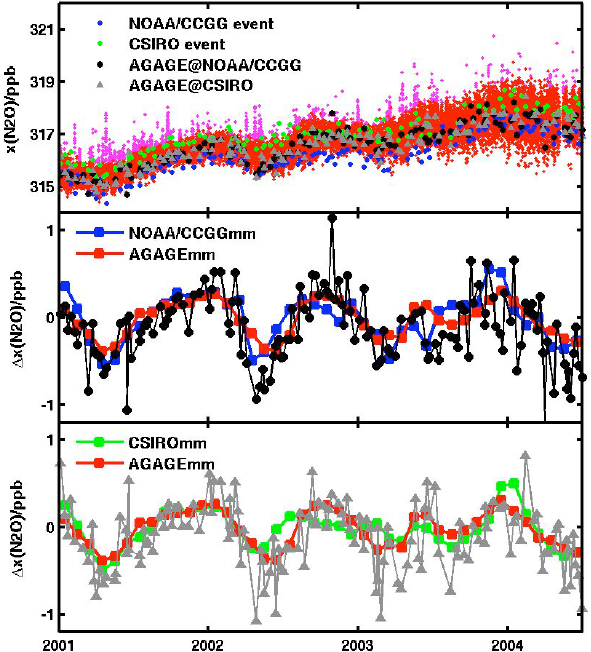
Fig. 4. (a) Same as Fig. 3a but for Cape Grim,Tasmania. Green dots are CSIRO event data. Gray triangles are AGAGE data sub- sampled at the time of CSIRO flask collection. (b) AGAGE data subsampled at NOAA/CCGG flask times compared to AGAGE and NOAA/CCGG monthly means. (c) AGAGE data subsampled at CSIRO flask times compared to AGAGE and CSIRO monthly means. All data in (b) and (c) have been detrended as described in Fig.